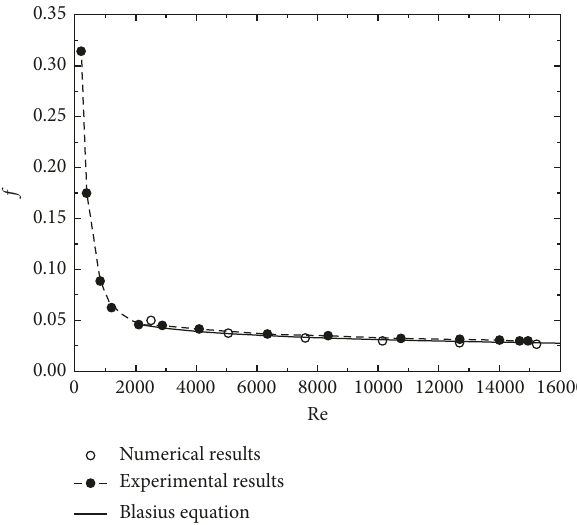
Figure 2: Comparison of friction factor of